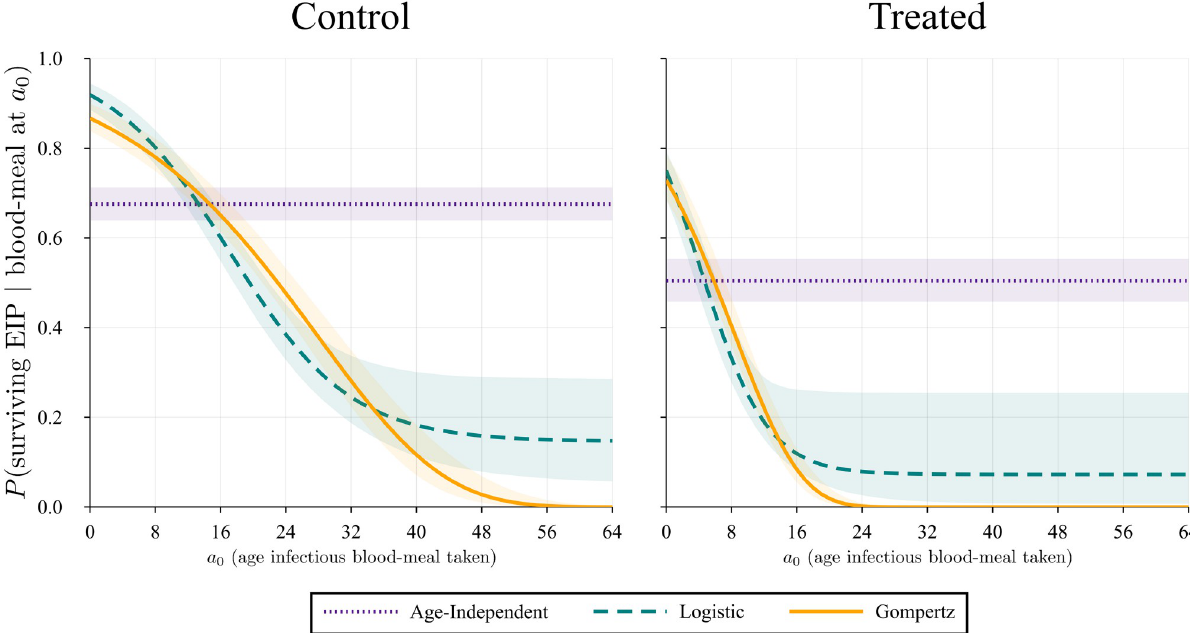
Fig 6. Probability the mosquito survives the extrinsic incubation period given that it takes an infectious blood-meal at age a 0 . The plots show the values of Eqs (11), (12) and (13) over different ages. The shaded area represents the 95% confidence interval due to the error propagated from the parameter estimates using Monte Carlo